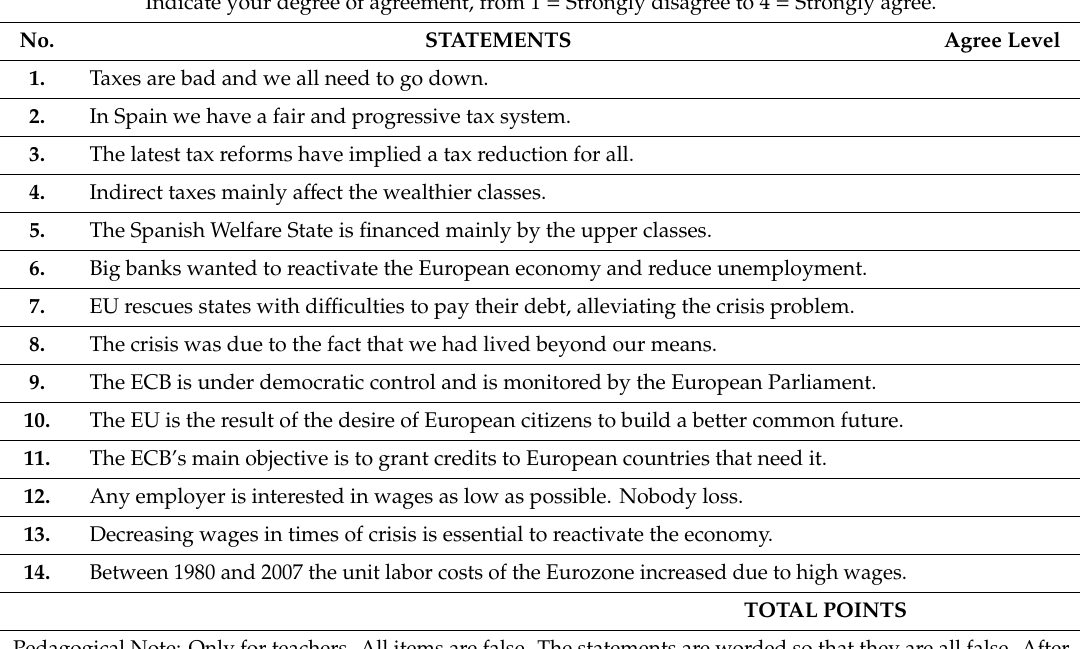
Table 2. Questionnaire about economic issues for economics